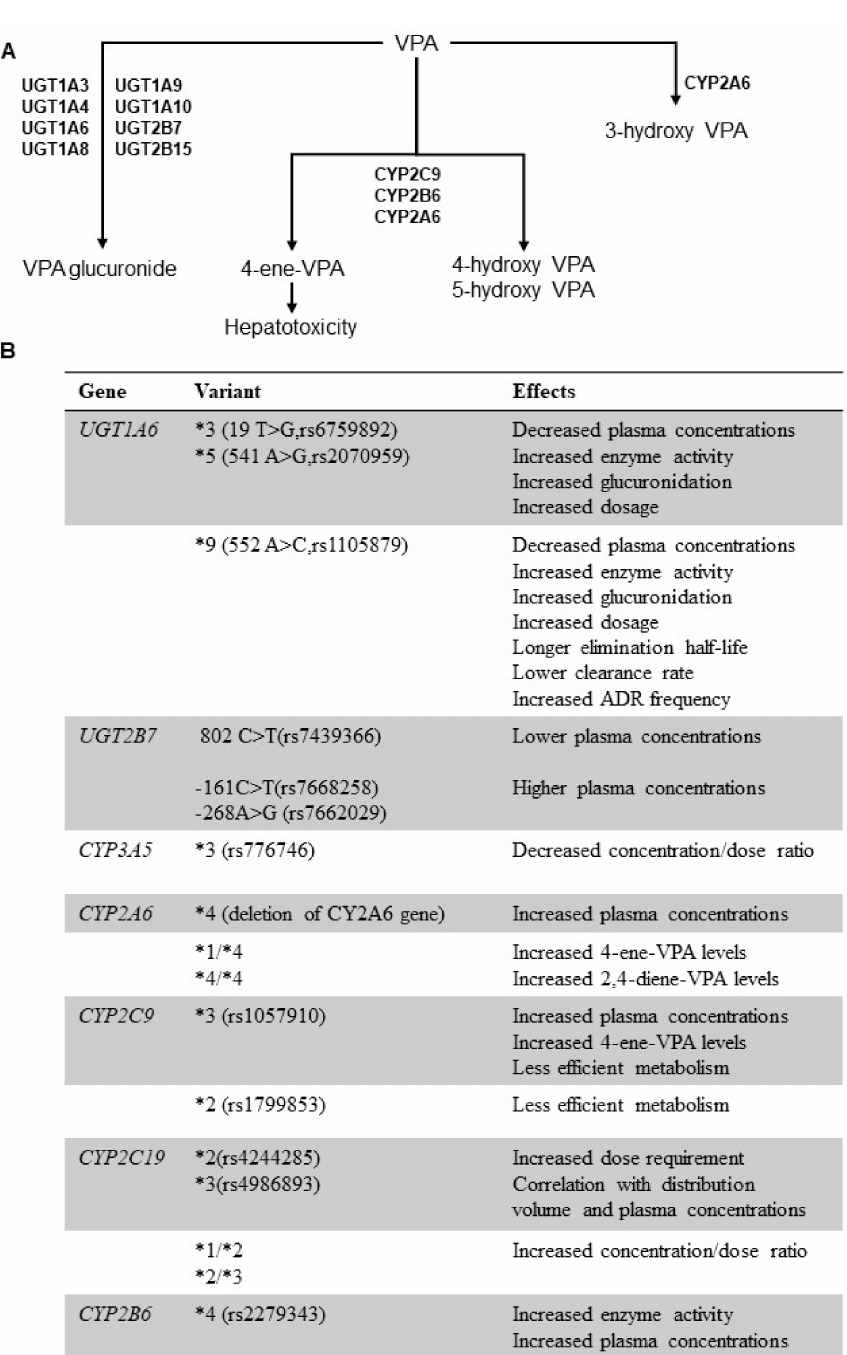
Figure 2. Pharmacokinetics (PK) and pharmacogenomics of valproate (VPA). ( A ) Liver metabolism of VPA by cytochrome P450 (CYP), UDP-glucuronosyltransferase (UGT) enzymes, and relative metabolites. ( B ) Genetic polymorphisms in genes involved in VPA metabolism and their effects on PK of the drug. Abbreviations. (*) allele nomenclature; ADR, adverse drug